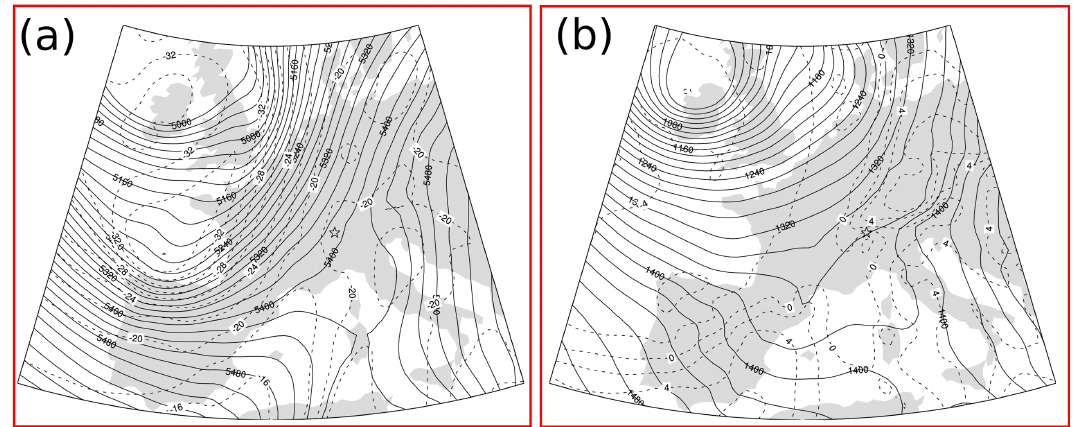
Figure 10. (a) 500hPa and (b) 850hPa geopotential height (m) (continuous lines) and temperature ( ◦ C) (dashed lines) over central Europe at 12:00UTC on 1 February 2014. The geographical location of the CLACE campaign is indicated by a star. The atmospheric fields are derived by ERA-Interim reanalysis grids at 0.5 ◦ × 0.5 ◦ horizontal resolution.